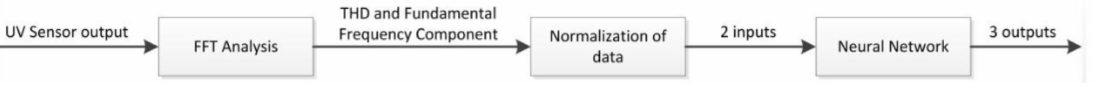
Figure 4. Process of patern recognition using